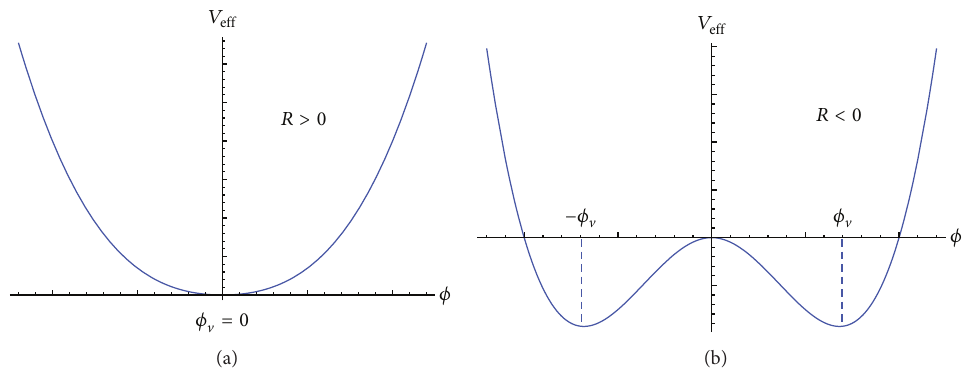
Figure 1: The effective potential 𝑉 eff = −𝜉𝑅𝜙 2 /2 + 𝑉 0 |𝜙| 10/3 with 𝜉 < 0 and 𝑉 0 > 0 , where (a) [unbroken phase] corresponds to the effective potential with a positive value of the curvature scalar 𝑅 , while (b) [broken phase] is a case of 𝑅 < 0 .